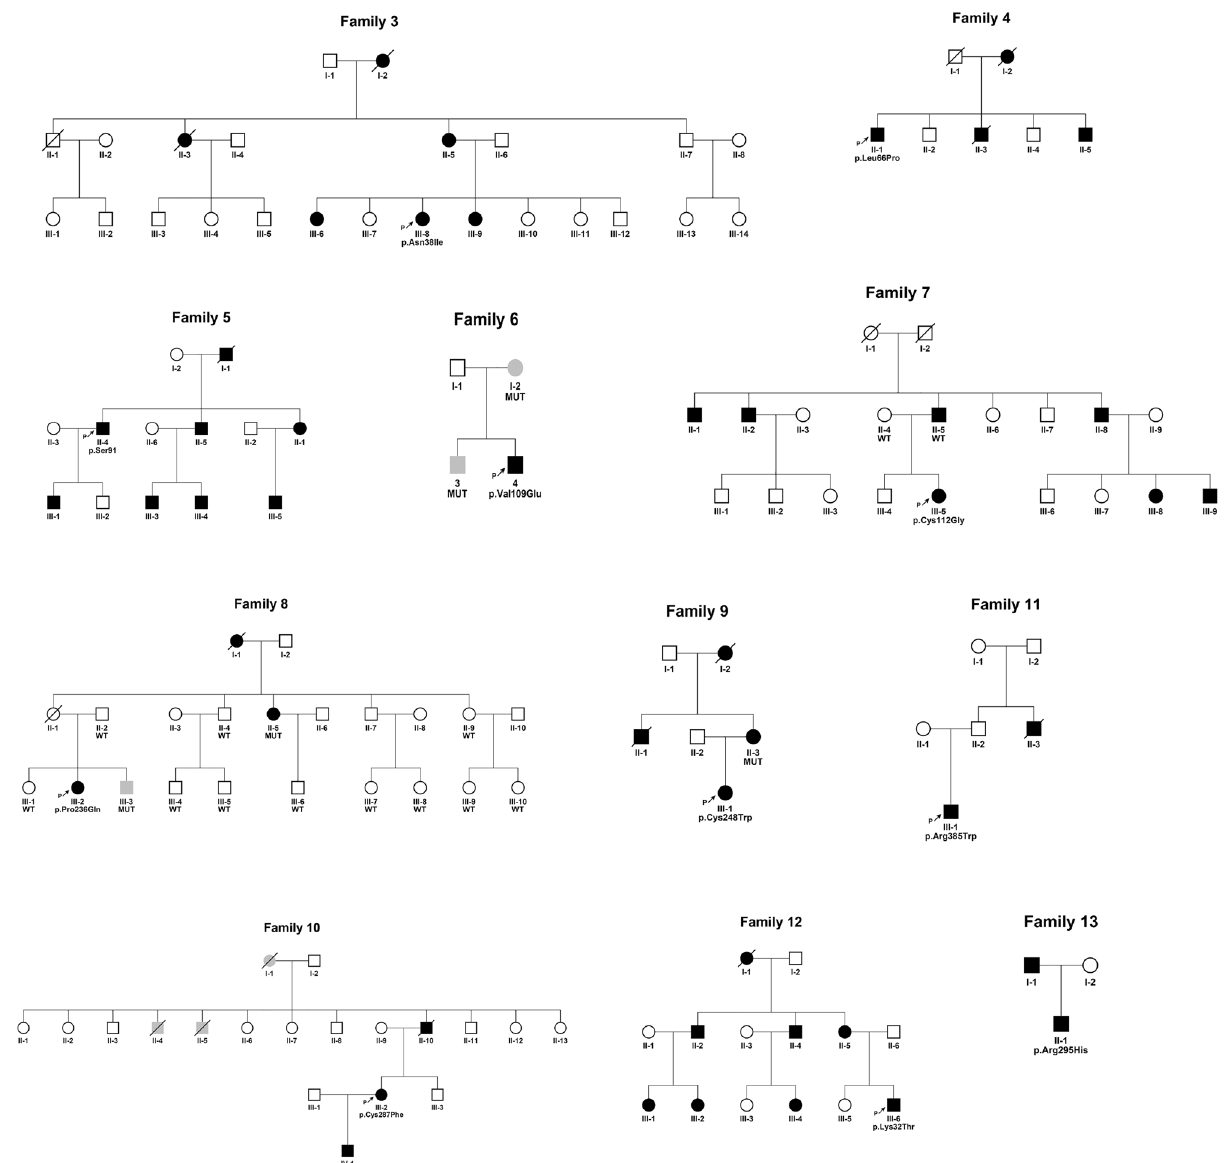
Figure 2. Pedigree information of the families. Proband from family 3–13 had a positive family history of ADTKD. Black symbols denoted clinically affected individuals. Open symbols denoted clinically unaffected individuals. Gray symbols denoted family members with variants but no clinical symptoms. Arrow denoted the proband and below the proband symbol are the amino acid symbols. Family 3, family 12 and family 13 had variants in genes UMOD, REN, and HNF1B, respectively. For the family members which genetic testing was performed the results were listed below the symbol. MUT Family members carried the same clinically significant variant as the proband, WT Individuals without pathogenic